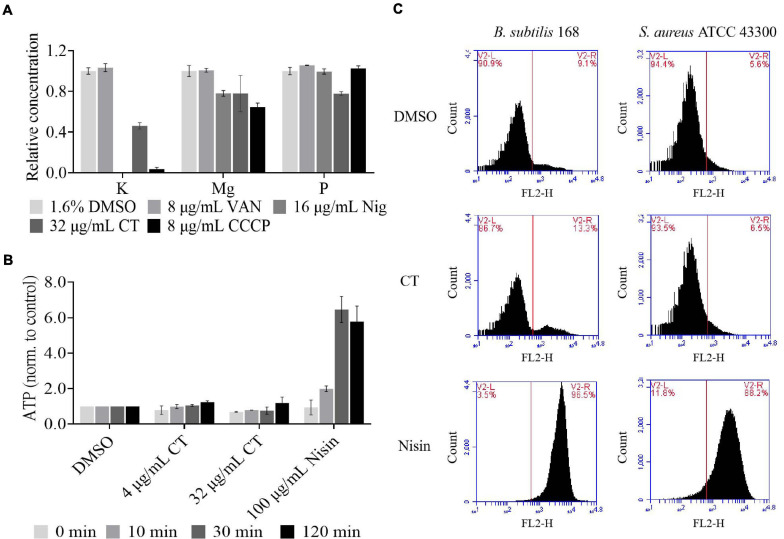
Effect of CT on bacterial membrane integrity. (A) Determination of cellular element concentrations of B. subtilis 168 by inductively coupled plasma optical emission spectroscopy after CT treatment for 30 min. DMSO, non-drug treated control; VAN (vancomycin), negative control; Nig (nigericin), specific potassium ionophore; CCCP, depolarization agent. The experiments were carried out in triplicate in two independent replications. (B) Leakage of ATP following exposure of B. subtilis 168 to antimicrobial agents. Nisin, a pore-forming agent. Data are presented as mean ± SD of three independent experiments with triplicate measurements. (C) Staining with propidium iodide. Representative data from three independent cultures of S. aureus ATCC 43300 and B. subtilis 168 were shown following exposure to antimicrobial agents at 8 × MIC for 120 min.